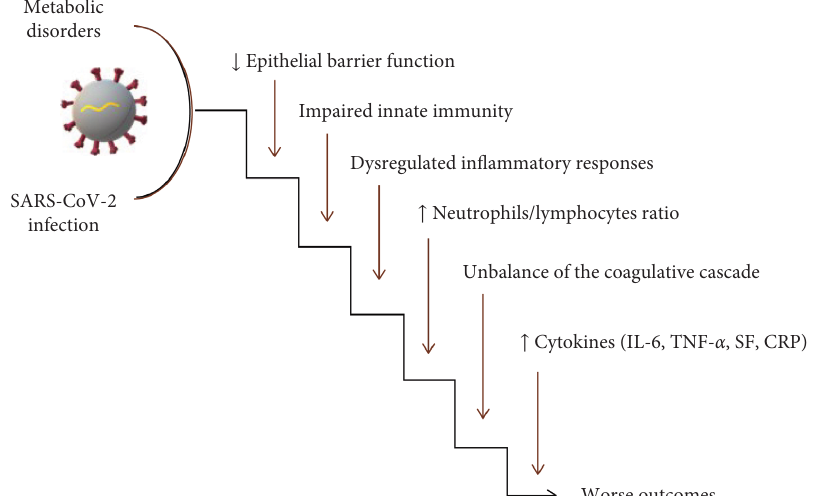
Figure 1: Molecular machineries responsible for the worsening of the SARS-CoV-2 phenotype and prognosis in patients with concomitant metabolic diseases. Biological functions such as inflammation, immunity, and epithelial defense mechanisms are